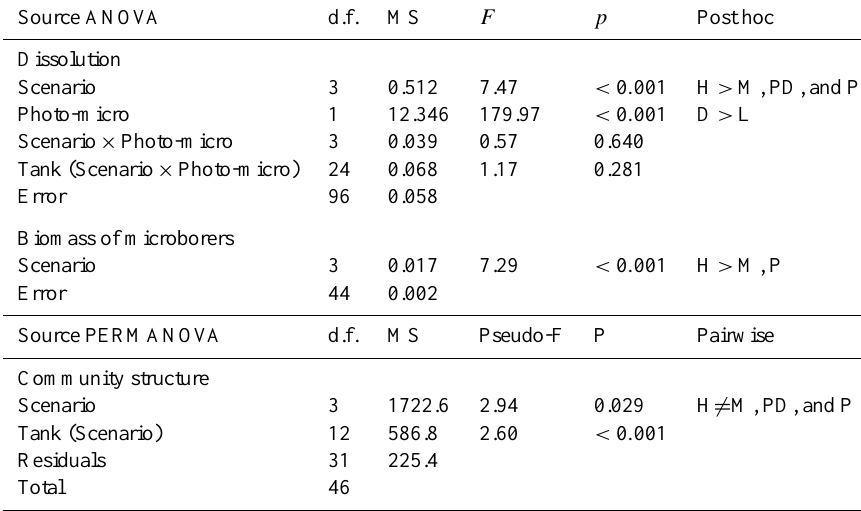
Table 2. ANOVA results of dissolution (%) and biomass of endolithic algae (mgcm − 2 ), and PERMANOVA results of endolithic community structure (%) in CCA skeletons. Analyses were conducted using (1) a two-way nested ANOVA to test the effect of p CO 2 -T scenarios on dissolution of light and dark CCA samples, (2) a one-way ANOVA to test the effect of p CO 2 -T scenarios on biomass of endolithic algae, and (3) a one-way nested PERMANOVA to test the effect of p CO 2 -T scenarios on endolithic community structure. d.f: degrees of freedom; MS: mean square; photo-micro: photosynthetic microborers; P: pre-industrial; PD: present day; M: medium; H: high p CO 2 -T. Source ANOVA d.f. MS F p Post hoc